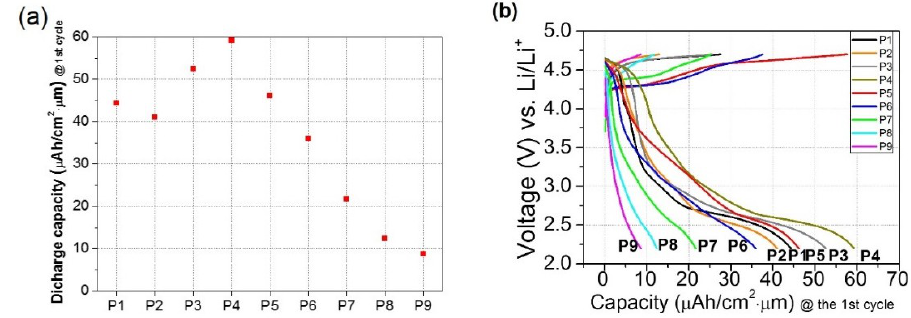
Figure 1. ( a ) Discharge capacities and ( b ) voltage profiles of all samples.